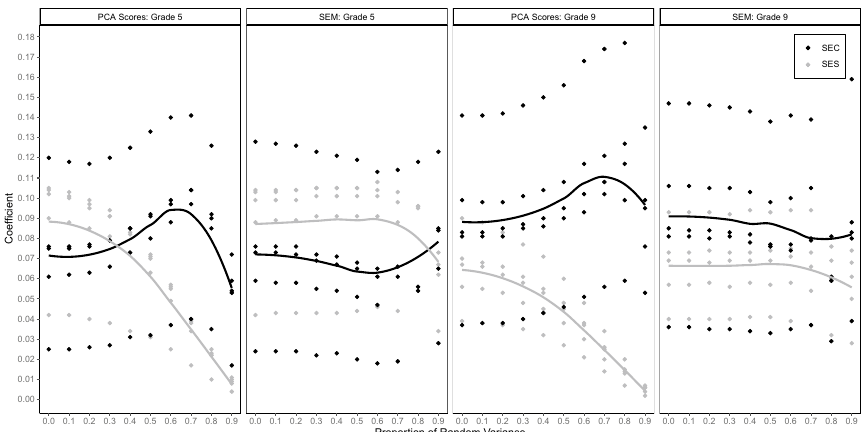
Fig. 3 Simulation results of increasing measurement error in multilevel PCA score and SEM. Dots are individual coefficients for each modelled academic domain and lines are best fit of modelled academic